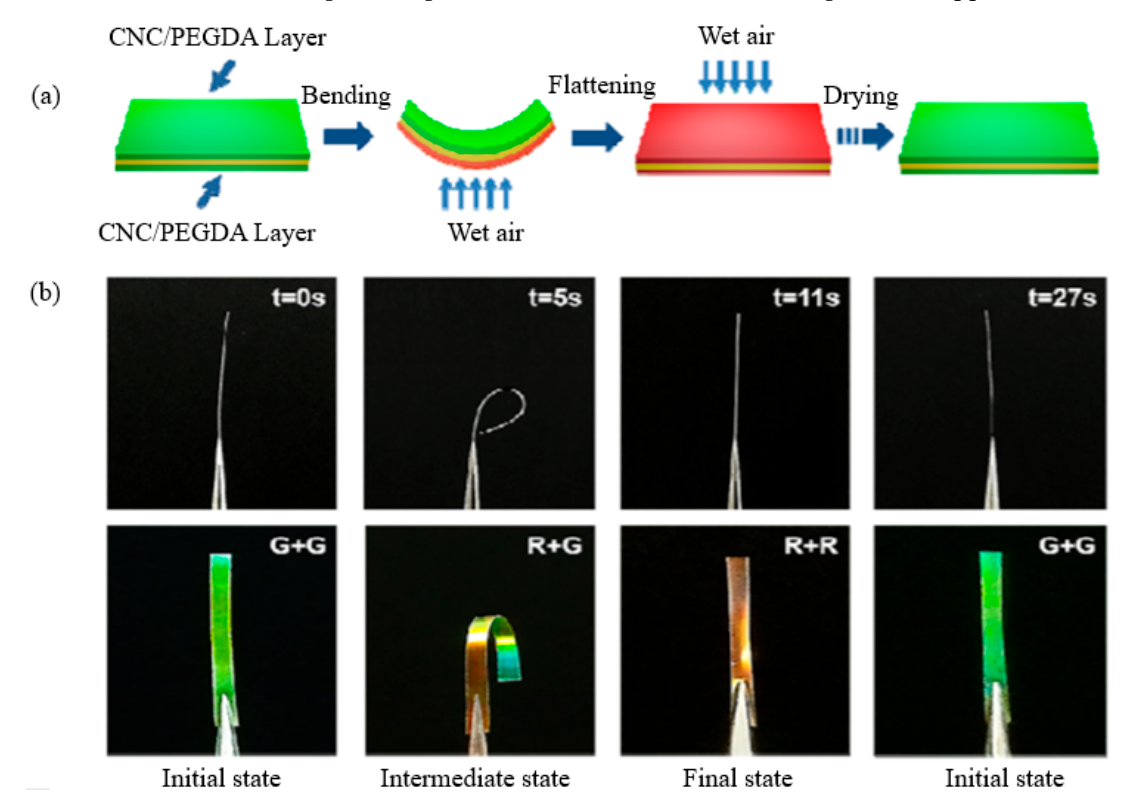
Figure 18. ( a ) Water vapor-based actuation in a sandwiched structure nanocomposite film is shown schematically; ( b ) images of the sandwiched nanocomposite film deformation and coloration. Reproduced from [116].